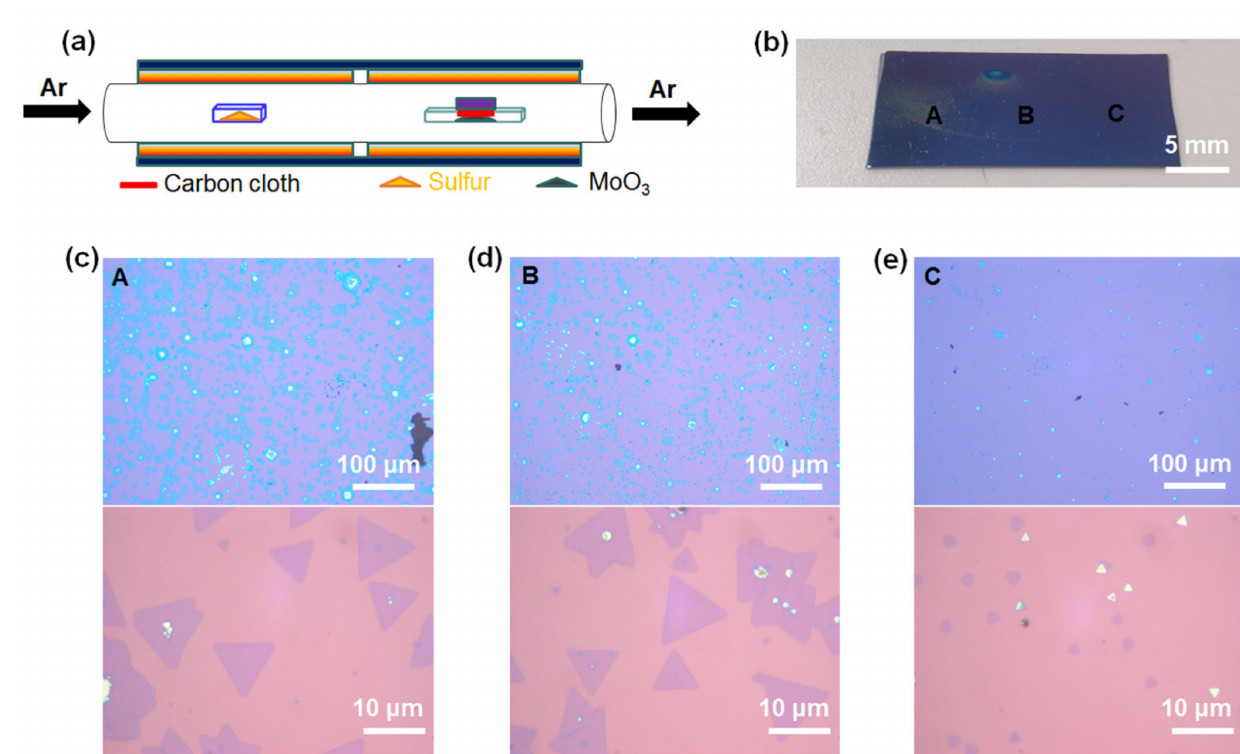
Figure 2. Carbon cloth-assisted CVD growth of monolayer MoS 2 . ( a ) Schematic illustration of the experimental setup for carbon cloth-assisted CVD growth of monolayer MoS 2 . ( b ) Optical image of monolayer MoS 2 grown on an SiO 2 /Si substrate. Low-magnification and high-magnification optical images of ( c ) region A, ( d ) region B, and ( e ) region C in ( b